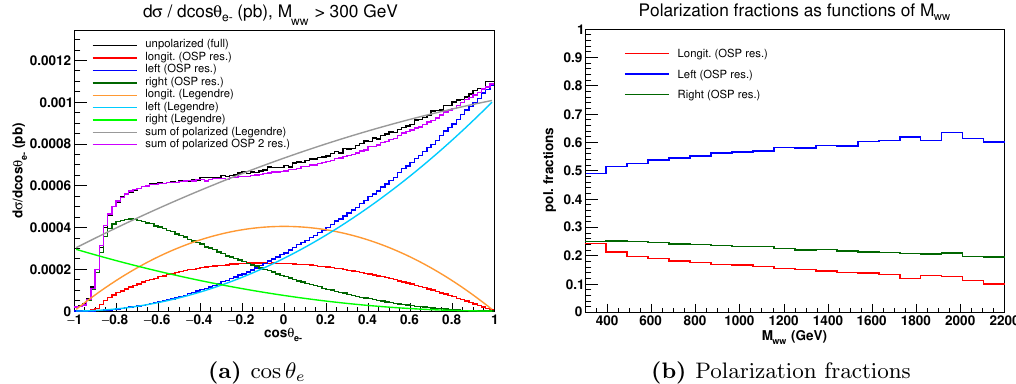
Figure 5. On the left, distributions of cos (cid:18) e in the W (cid:0) center of mass frame; on the right, the polarization fractions as functions of M WW . p e